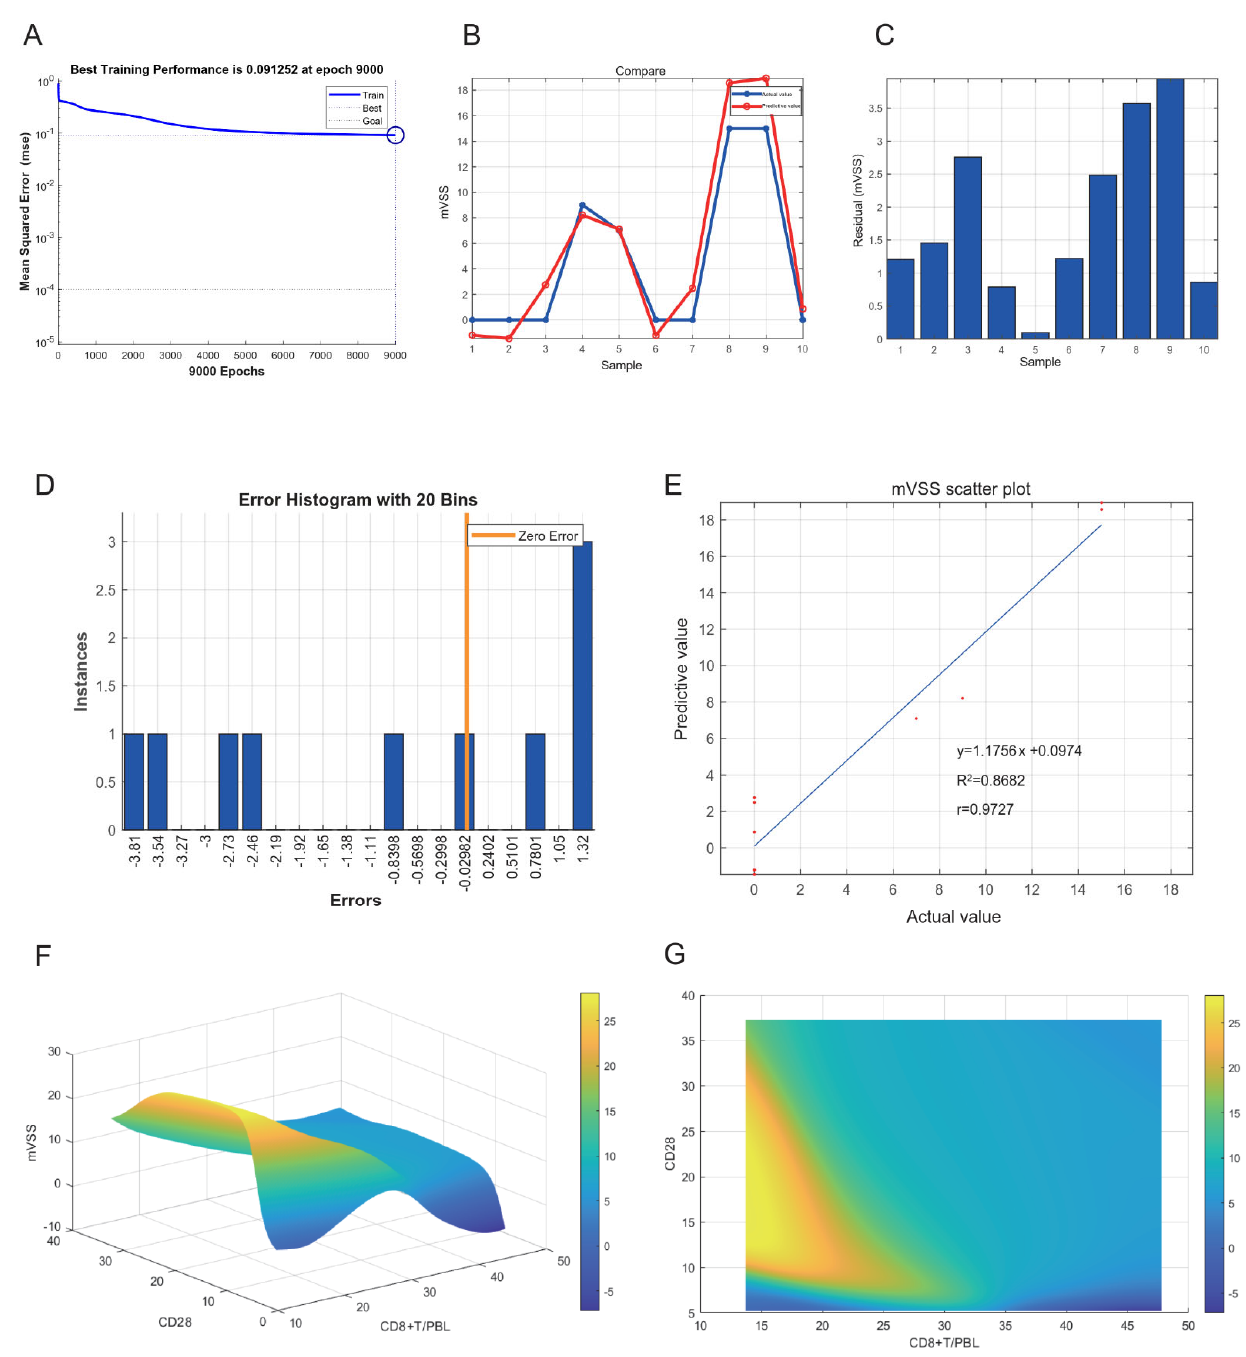
Figure 10. ( A ) The neural network model for predicting the severity of keloids. The best training performance was 0.091252 at epoch 9000. ( B ) The predictive value of the data was verified against the actual value. ( C ) Absolute error diagram between the predicted and actual values of the data. ( D ) Error distribution map between the predicted and actual values of the data. ( E ) Correlation scatter plot of mVSS. y = 1.1756x + 0.0974, R 2 = 0.8682, r = 0.9727. ( F , G ) The high ‐ risk warning range of CD28 and CD8 + T/PBL at the planform and three ‐ dimensional levels.